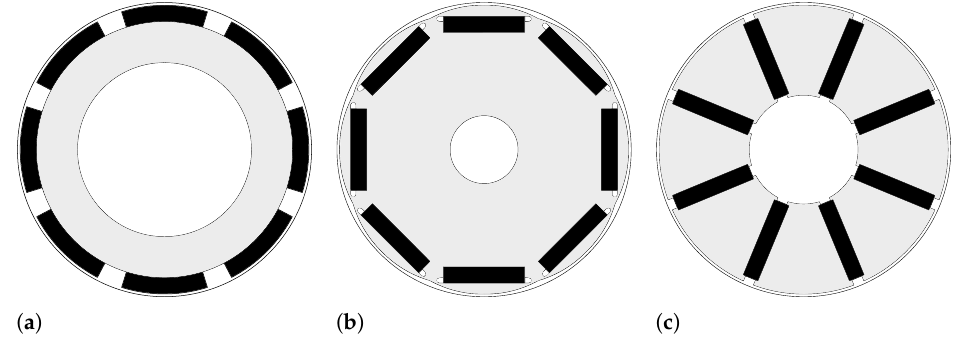
Figure 15. Rotor geometries without shaping. ( a ) Surface-mounted PM. ( b ) Interior PM. ( c ) Interior PM